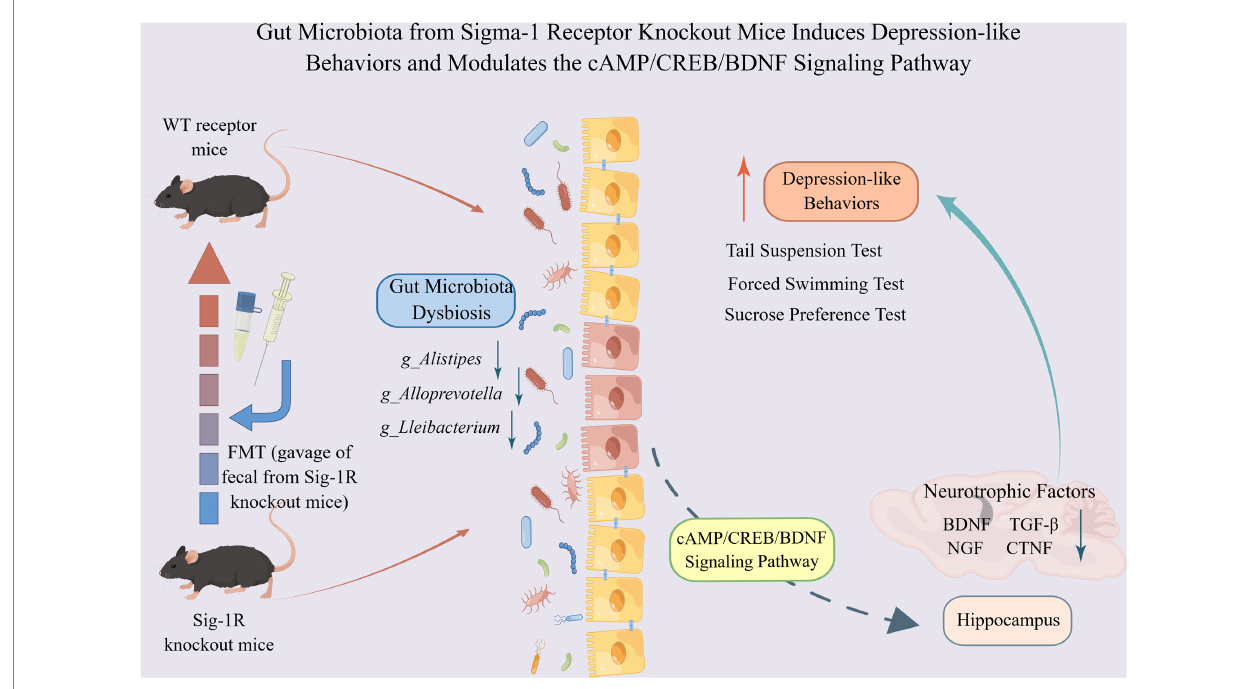
FIGURE 6 Gut microbiota from Sigma-1 receptor knockout mice induces depression-like behaviors and modulates the cAMP/CREB/BDNF signaling pathway. Sig-1R knockout induced increased depression-like behaviors in mice with decreased neurotrophic factors, which may be mediated by gut microbiota. The microbiota from Sig-1R knockout mice was sufficient to cause a depression-like phenotype and a reduction in neurotrophic factors. Gut microbiota may regulate the expressions of neurotrophic factors through the cAMP/CREB/BDNF signaling pathway. By